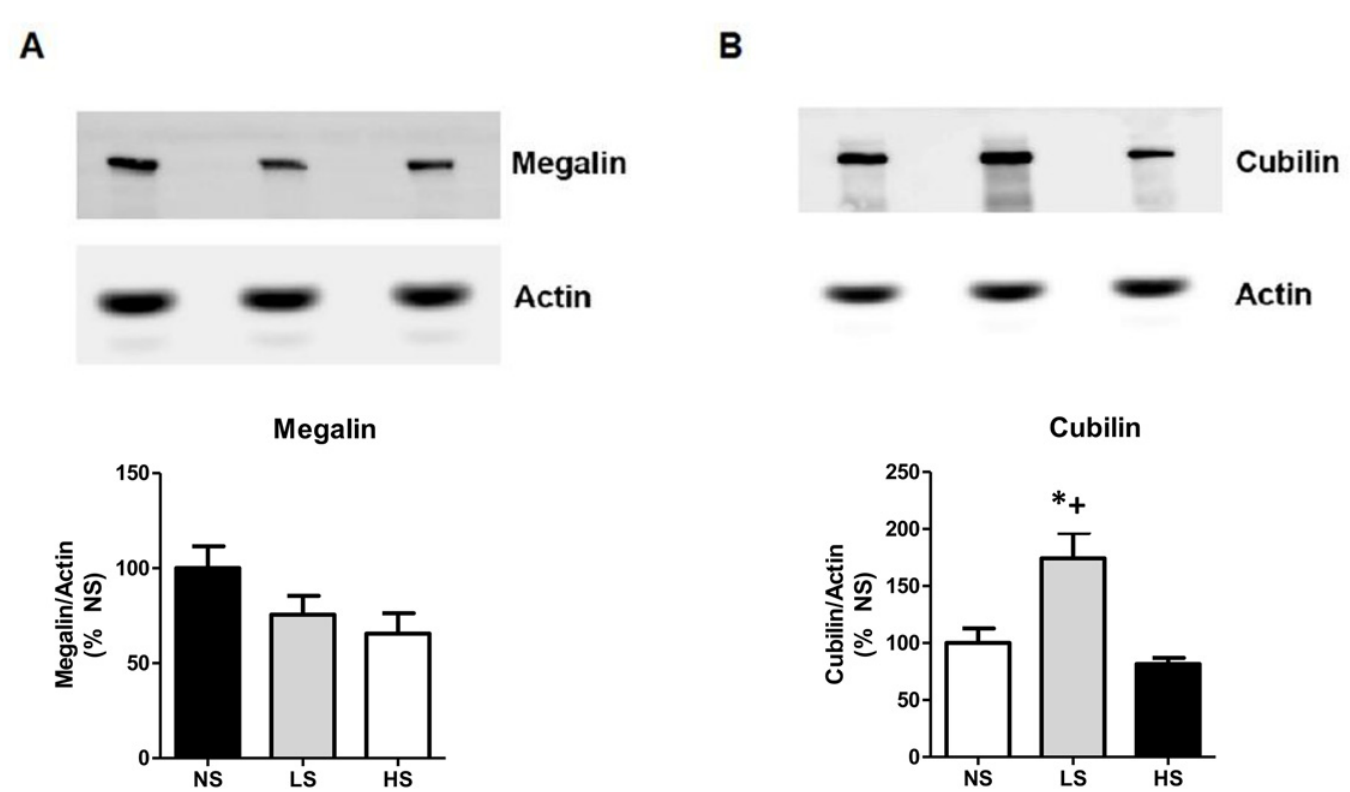
Fig 5. Analysis of megalin and cubilin renal protein expression. (A) Megalin. (B) Cubilin. Data are means ± SEM. (NS) normal salt diet. LS: low salt diet. HS: high salt diet. * P < 0.05 vs. NS; + P < 0.05 vs. HS. (n = 6 / group).